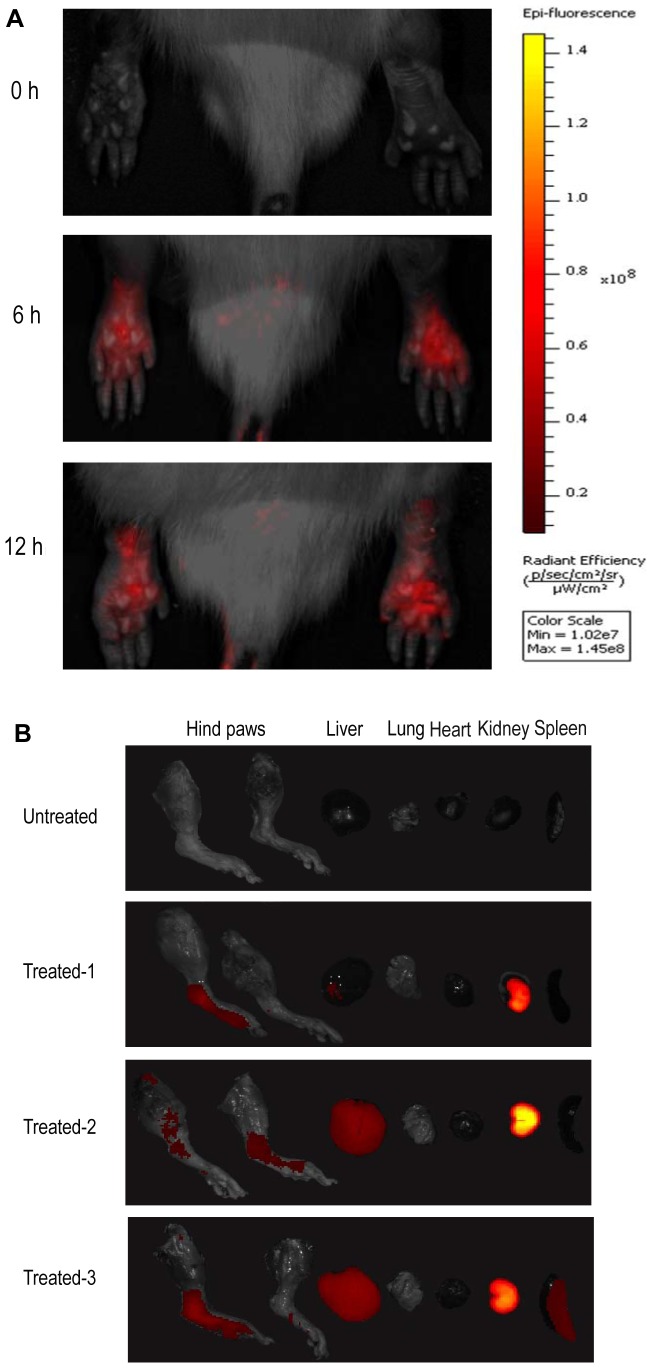
Tissue distribution of PEI/Cy5-siRNA polyplexes.The particles were administered as a single dose (0.6 mg siRNA/kg) to AA rats via tail vein. Images were taken with IVIS imaging system. 0 h represents the non-injected control. (A) In vivo fluorescence images of the arthritic paws at 6 and 12 h post-injection. Shown are representative of 3 rats per group. (B) Fluorescence images of major organs. Rats were killed 12 h after injection. Hind ankle joints and various organs (heart, liver, spleen, lung, and right kidney) from three rats were isolated and imaged.